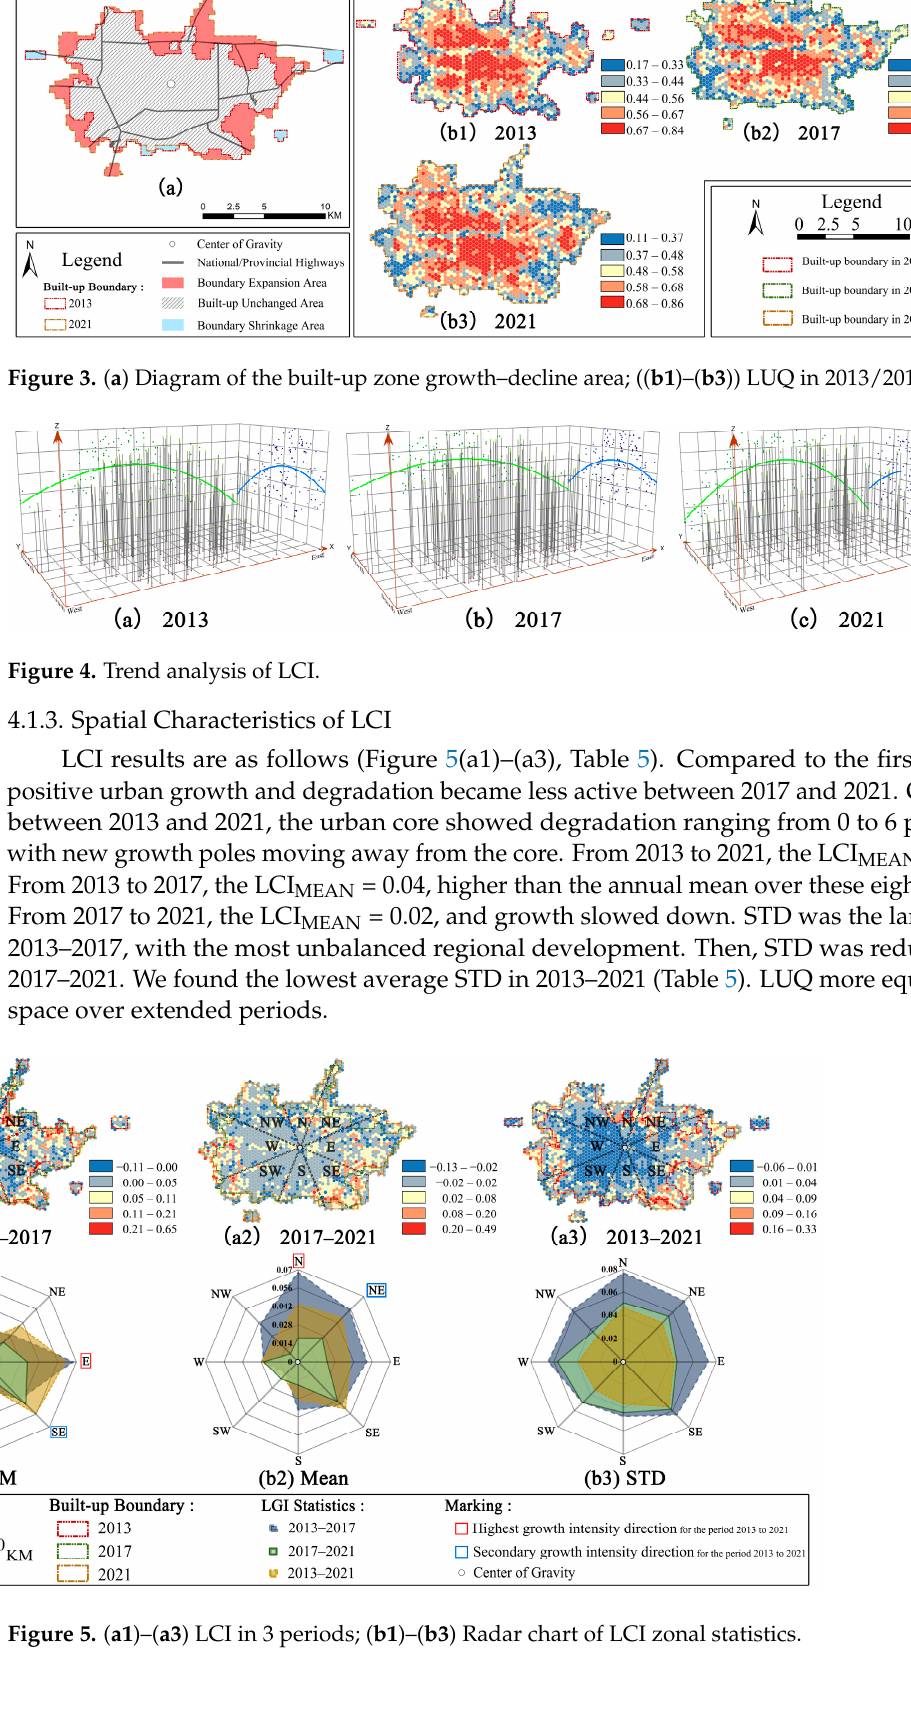
Figure 5. ( a1 )–( a3 ) LCI in 3 periods; ( b1 )–( b3 ) Radar chart of LCI zonal